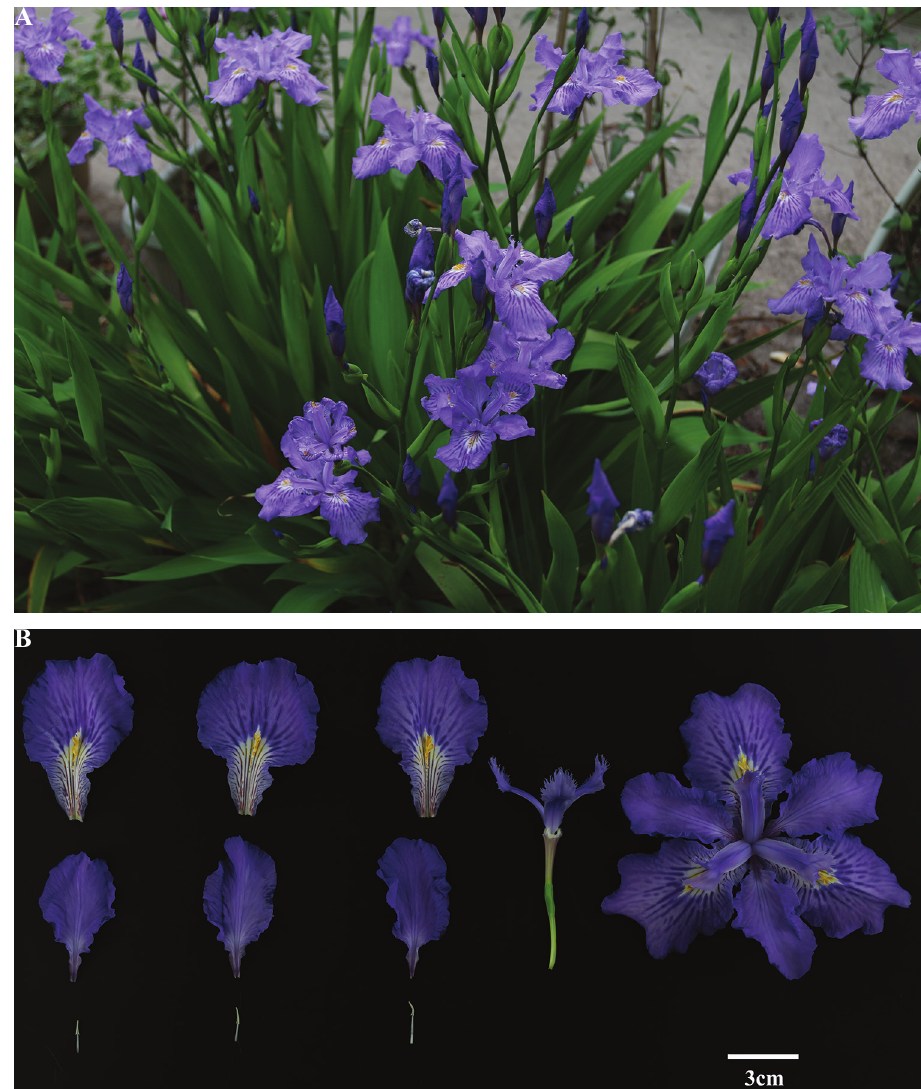
Figure 2. A Iris × ampliflora in flower B flower anatomy of Iris × ampliflora